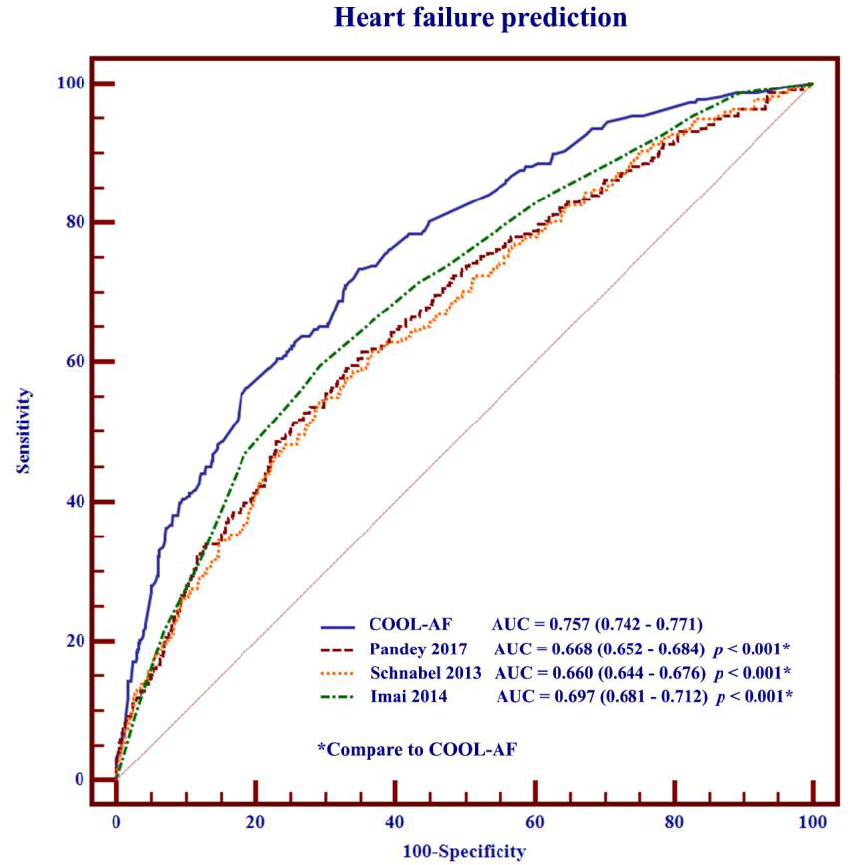
Figure 5. Comparisons of C-statistics of COOL-AF model with Pandey et al. [15], Schnabel et al. [16], and Imai et al. [17] (AUC = area under the curve). * Statistical significance